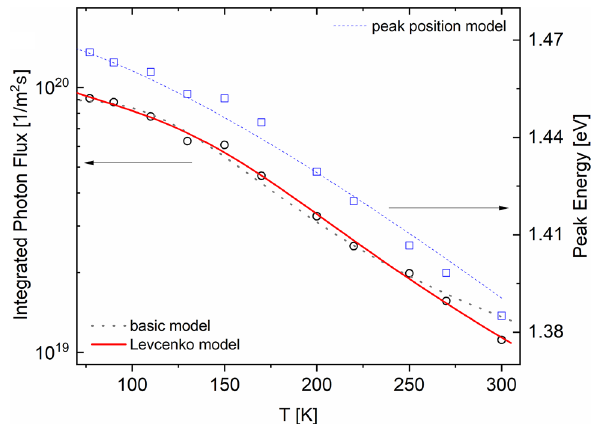
Figure 7. The total FB flux and max peak energy as a function of temperature for the data in Fig. 5. The dotted dark curve is the least square fit of Eq. (3) to the data and the solid red curve is the best fit based on Eq. (4). The blue dotted curve is the E peak (T) fit to the peak energy data. The Levcenko model best fit parameters are: α = 0.35, E A = 41.3 meV, A = 4.2 × 10 20 m -2 s -1 and the C =